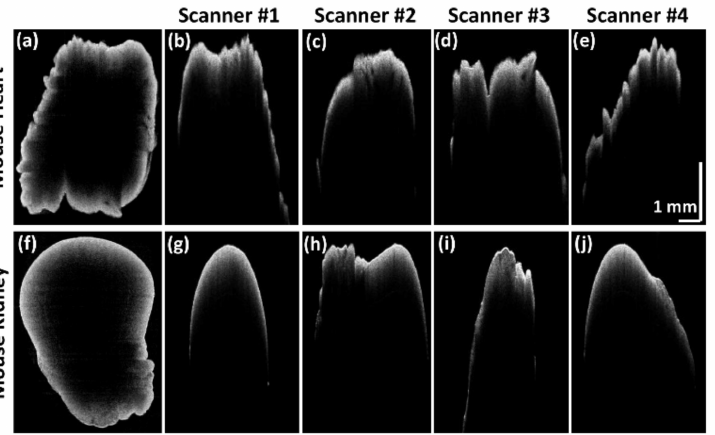
Figure 7. Enface and cross-sectional OCT images of mouse heart and kidney specimens. ( a ) and ( f ) are the enface images of mouse heart and kidney, respectively. ( b – e ), and ( g – j ) are the cross-sectional OCT images of mouse heart and kidney,